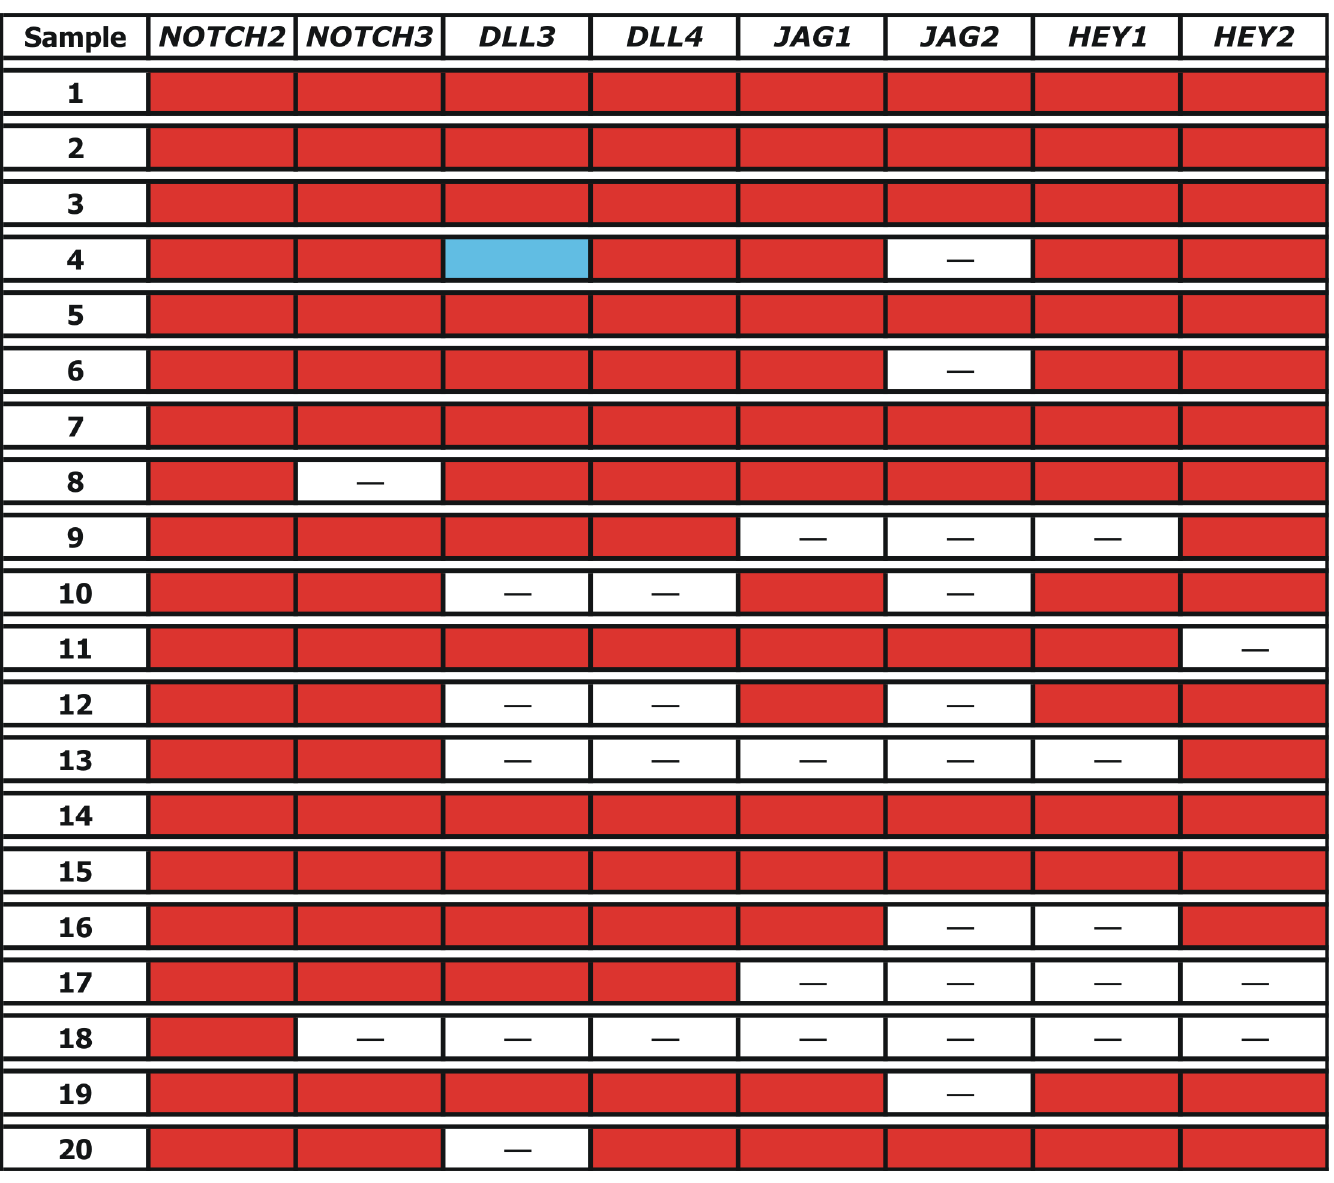
Fig 2. Schematic representation of Notch pathway molecules mRNA expression profile in our series of preeclampsia-complicated late preterm and term placentas. Red: Downregulation; White: Normal expression; Sky Blue: Overexpression.